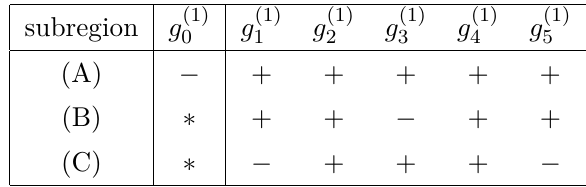
Table 3 . Signs of the pure one-loop functions (3.26) in different kinematic regions. The symbol ∗ means that our numerical analysis found both positive and negative signs within the